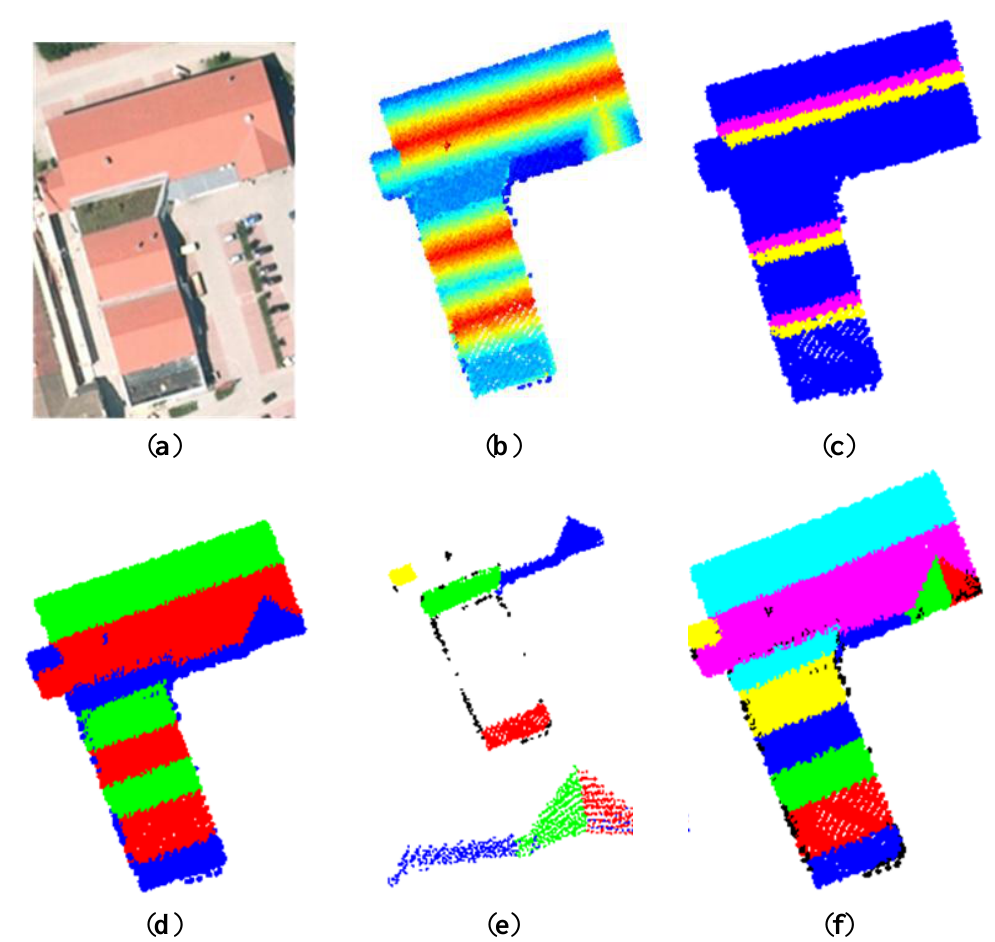
Figure 3. Segmentation of a complicated roof: ( a ) aerial photo from Google Map. ( b ) the roof point cloud sorted by height. ( c ) seed points (yellow and magenta dotes) of roof facets along roof ridges at first level. ( d ) segmentation of roof facets (red and green dotes) along roof ridges at first level, the blue dotes are the rest points. ( e ) clustering of the remaning points ( Upper ) and segmenation along the ridge at the second level ( Lower ). ( f ) final result, black dots are the